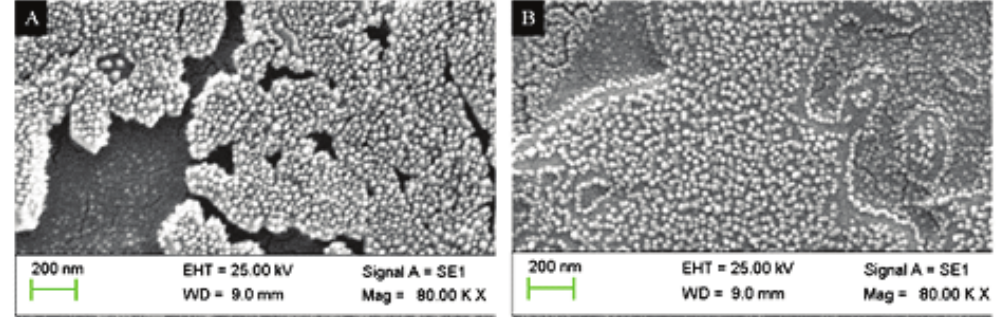
Figure 3. SEM images of CMD-TMC-NPs (A) and CMD-TCs-NPs (B).